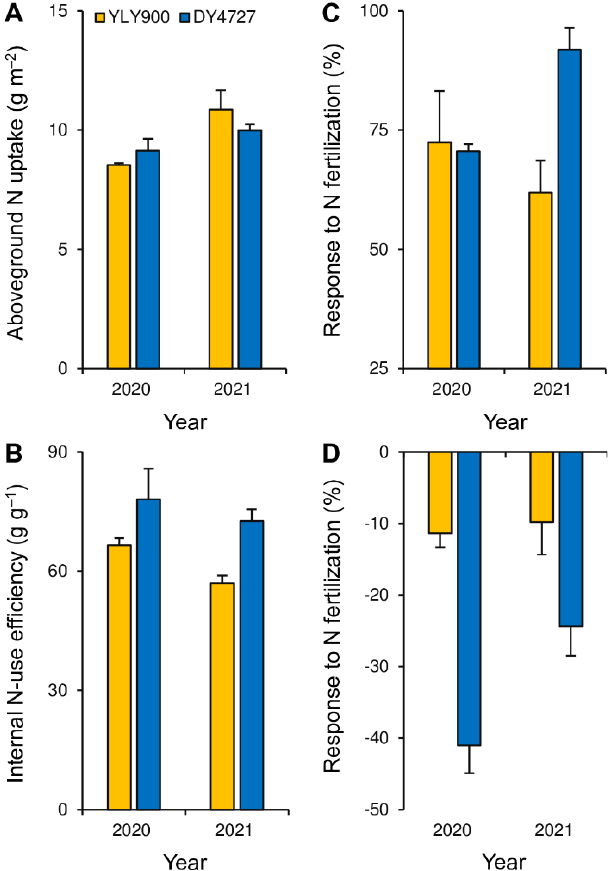
Figure 6. Aboveground N uptake ( A ) and internal N-use efficiency ( B ) under the zero-N fertilization condition and their responses to N fertilization (180 kg N ha − 1 ) relativized to zero-N fertilization ( C , D ) in two hybrid rice varieties, Deyou 4727 (DY4727) and Y-liangyou 900 (YLY900), grown in 2020 and 2021. Data are means (columns) and standard errors (bars) of three replications.